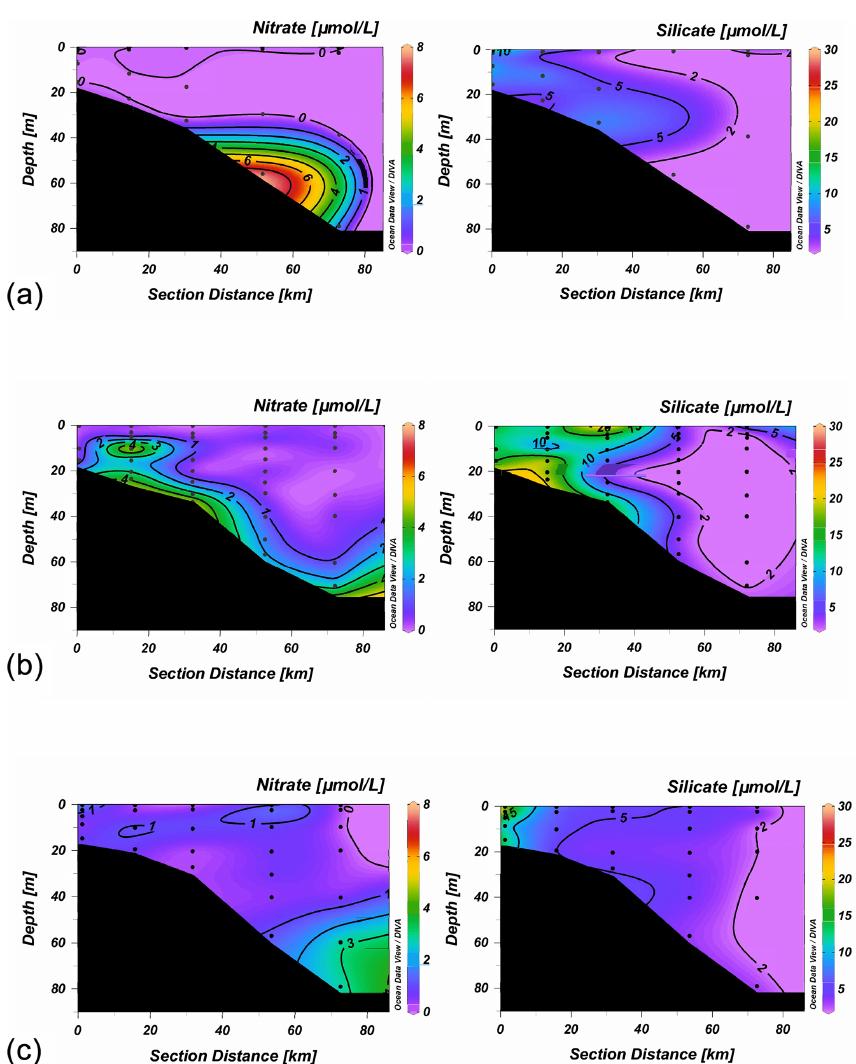
Figure 6. Nitrate and silicate (µmolL − 1 ) sections along line 3 (stations 11–15) during the August cruise (a) , the first September cruise (b) and the November cruise (c)